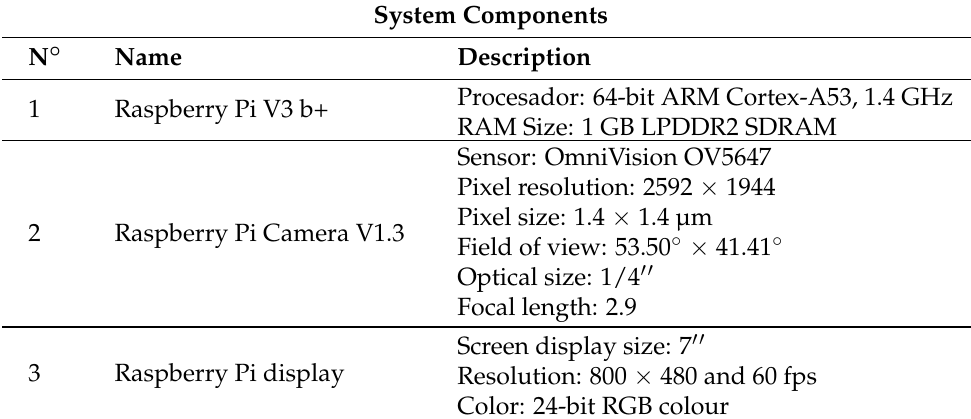
Table 2. Components of the data acquisition